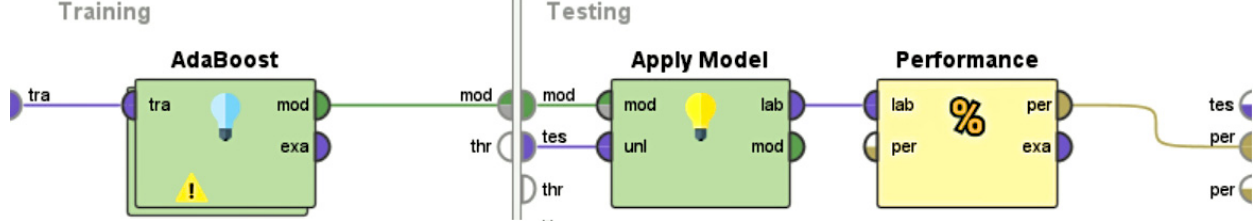
Figure 2. The cross-validation sub-process of the process shown in Figure 1 that shows the training and testing components of the main RapidMiner process.